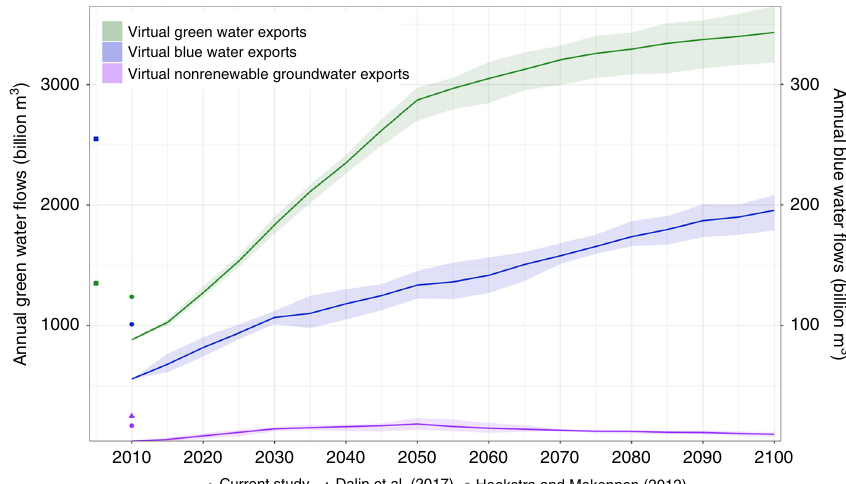
Fig. 1 Annual water fl ows of green, blue, and groundwater embedded in agricultural trade for SSP2-RCP6.0. Range of virtual green and blue water exports and the amount of nonrenewable groundwater depletion embedded in agricultural trade for all SSP2-RCP6.0 scenarios ( n = 6 total scenarios), including effects of GCM uncertainty. Virtual green exports are shown on the primary y -axis (left) while virtual blue and nonrenewable groundwater exports are represented on the secondary y -axis (right). Solid lines represent the average for each water fl ow in SSP2-RCP6.0, while ribbons depict the full range of GCMs for the RCP6.0 scenario. Previous estimates of virtual water trade are shown as points and expanded upon in Table 1. Current study values are based on FAO country-level trade in 2010, all future estimates are between 32 GCAM regions.